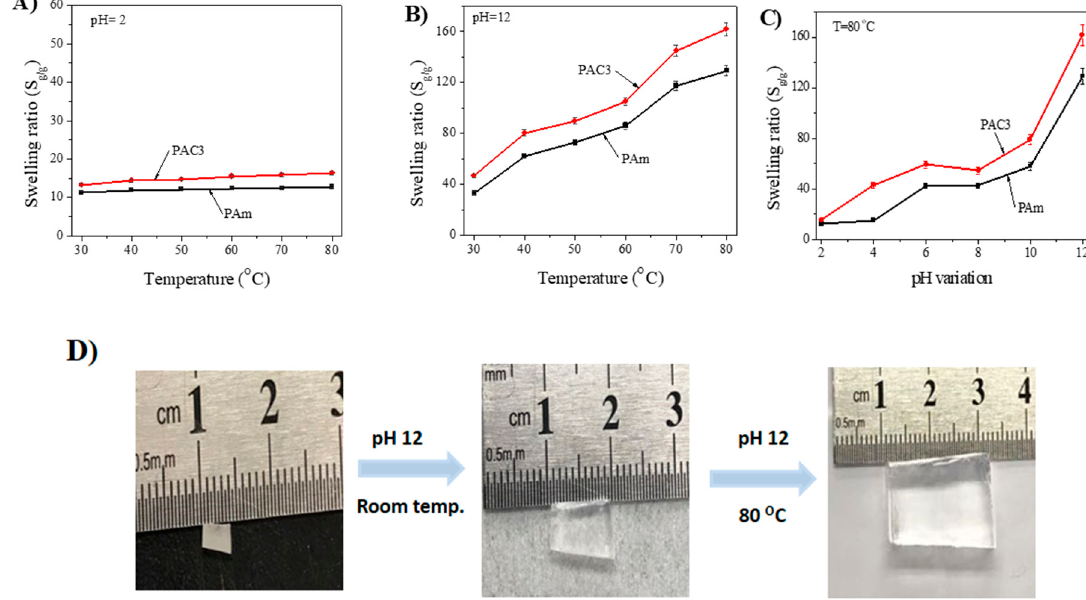
Figure 9. Swelling ratio studies ( A ), pH 2 ( B ) pH 12 at various temperatures, ( C ) swelling ratio at 80 ◦ C in di ff erent pH solutions, and ( D ) digital images of swollen hydrogels in pH 12 room temperature and 80 ◦